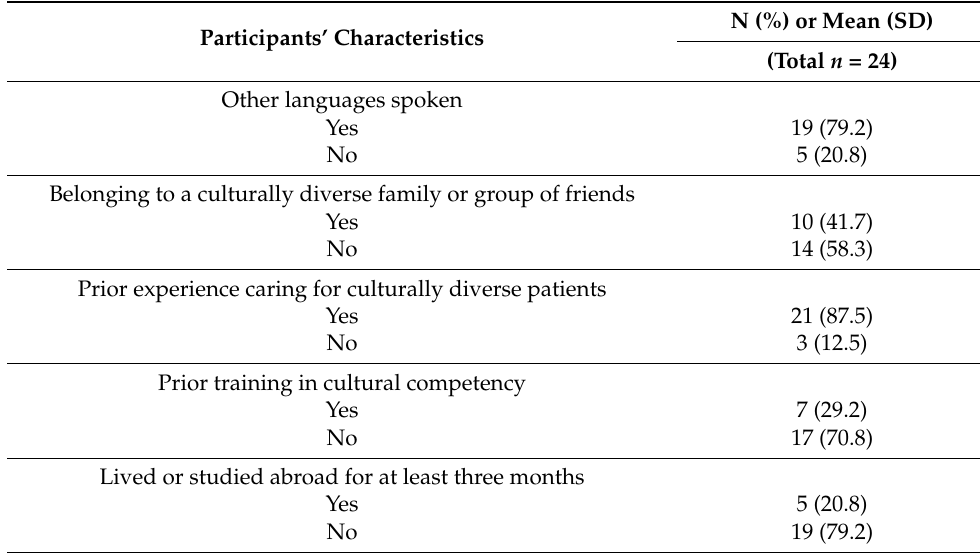
Table 3. Cont. Participants’